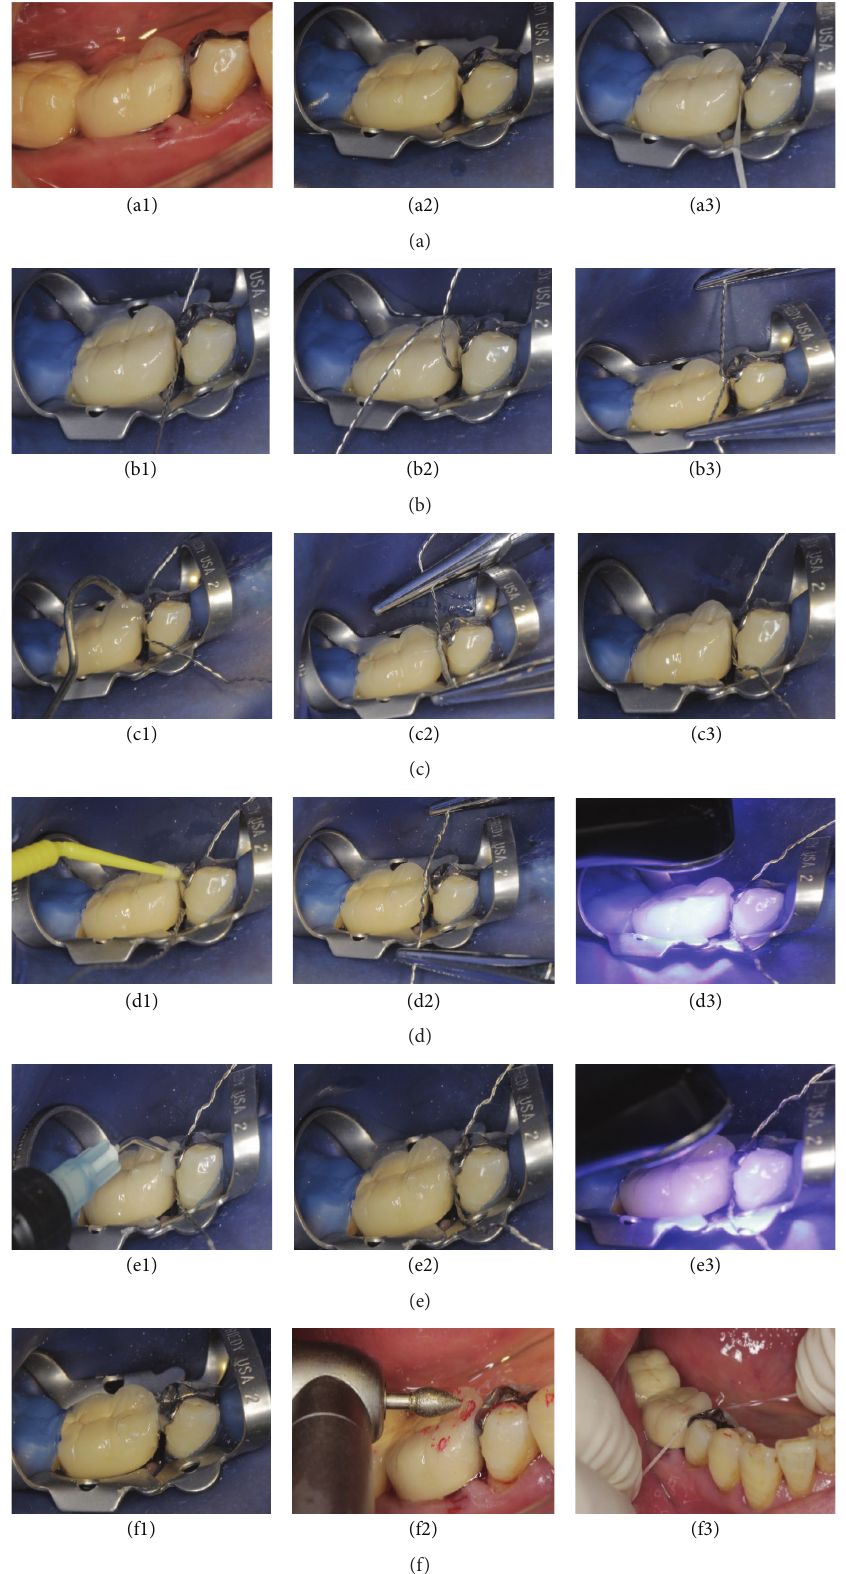
Figure 6: The steps of treatment for food impaction at the right mandible teeth in a typical case. (a) Evaluating the contact area by unwaxed dental floss. (b) Selecting the stainless wire for tension around the contact area. (c) Using 10% HF gel to etch the open contact area. (d) Applying the primer and bond resin to the etched surface. (e) Injecting the flowable composite resin or composite resin cement around the contact area and light curing. (f) Occlusal adjustment, polish, and finish of the